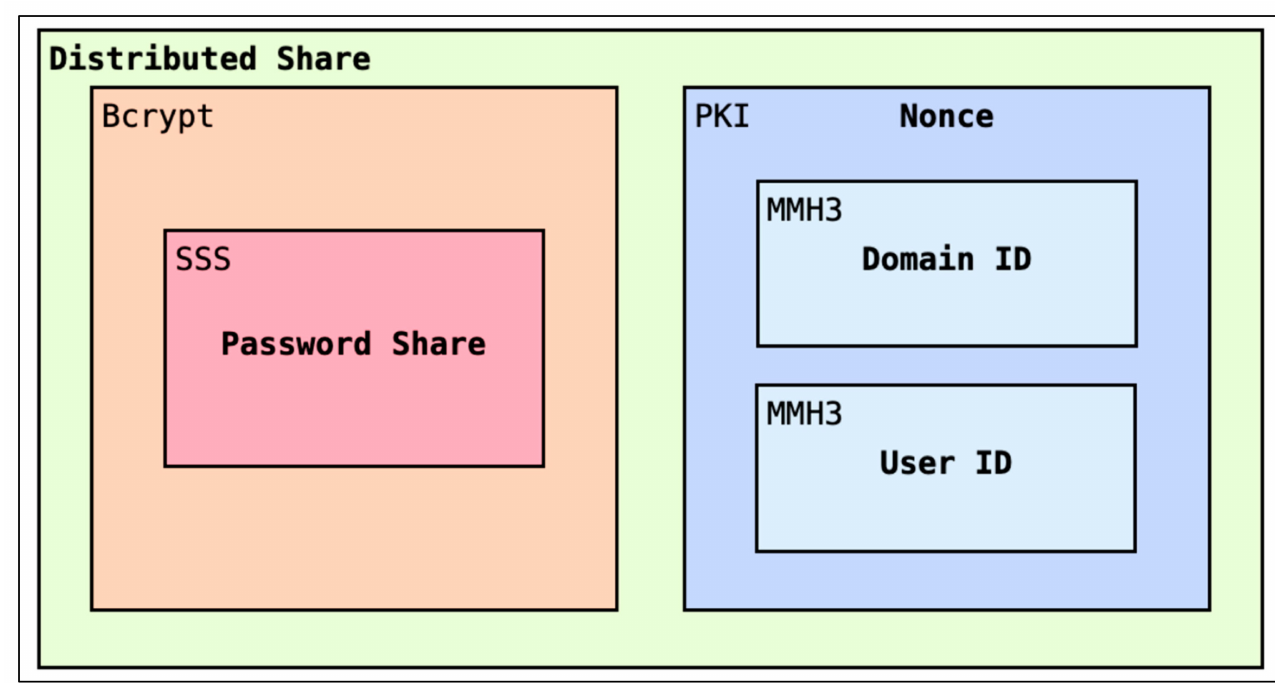
Figure 4. Cryptography used for distributed secret